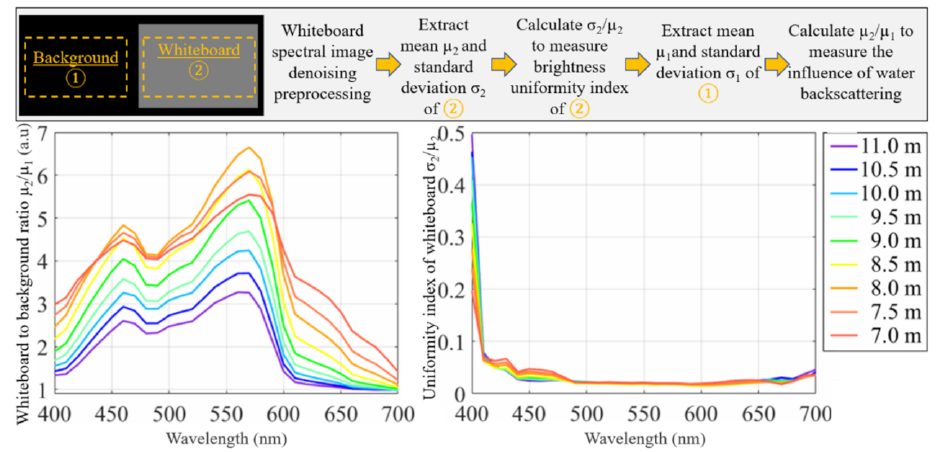
Figure 10. Spectral characteristics of remote target whiteboard illuminated by underwater LED light source.